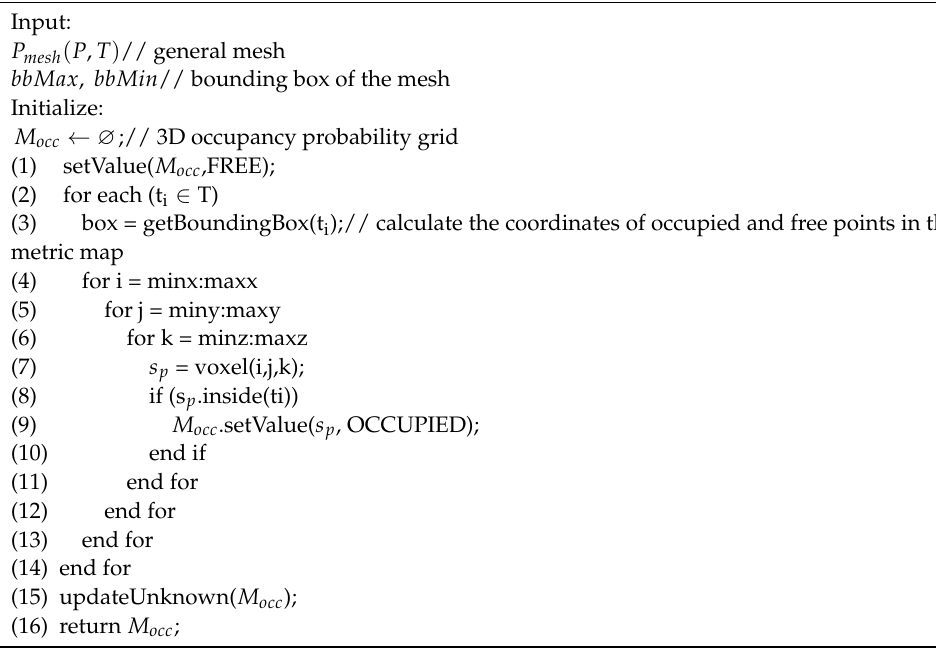
Algorithm 3. 3D occupancy probability calculation for a general